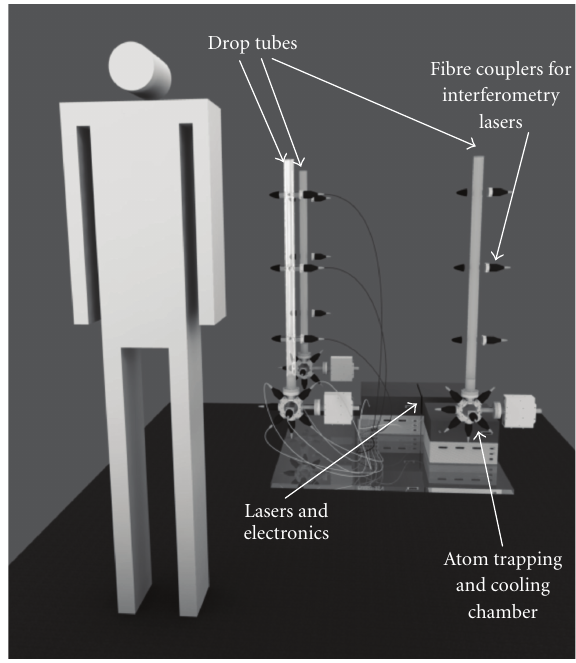
Figure 4: Schematic of the potential layout of the gravity gradient sensor. It is envisaged that the sensor will ultimately occupy a volume of 1m 3